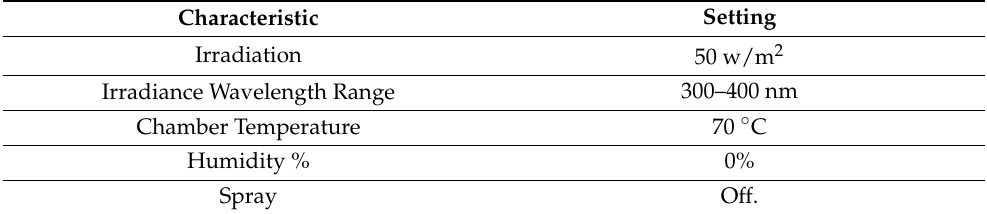
Table 3. Weathering chamber